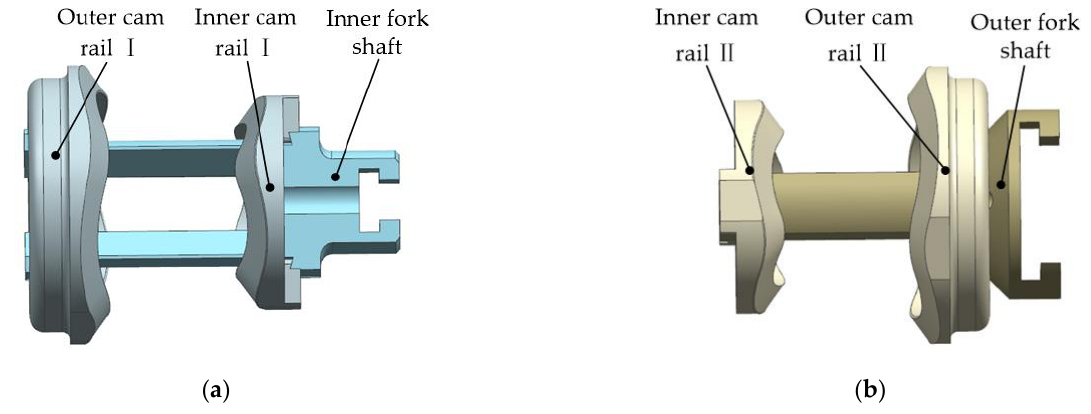
Figure 4. Schematic diagram of cam rail sets: ( a ) structure of the cam rail set I; ( b ) structure of the cam rail set II.